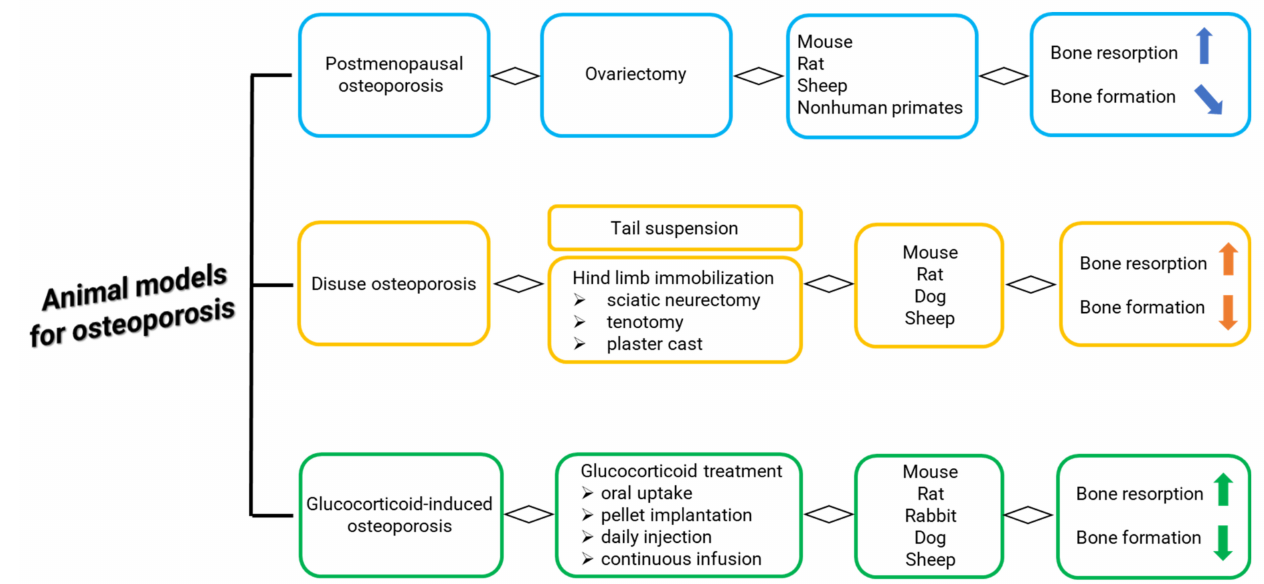
Figure 1. Main methods and animals for generation of (1) postmenopausal osteoporosis, (2) disuse osteoporosis, and (3) glucocorticoid-induced osteoporosis